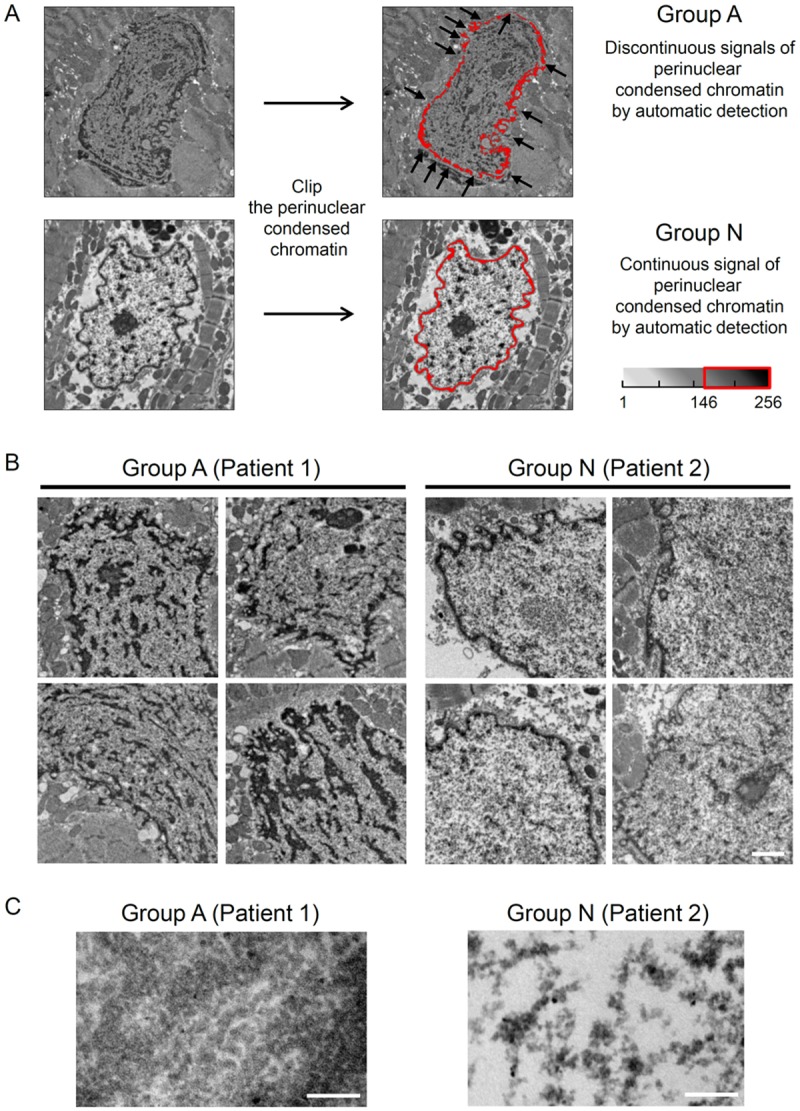
Classification of Groups A and N Based on Quantitative Analysis.(A) Representative original electron microscopic images before digital analysis are shown (10,000× magnification). The perinuclear condensed chromatin was isolated automatically using image analysis software. The area of perinuclear condensed chromatin, which is defined as the area with a grayscale value between 146 and 256, is outlined in red. Black arrows indicate areas of discontinuous nuclear periphery (discontinuous signals of perinuclear condensed chromatin by automatic detection). (B) Two types of nuclei, Group A and Group N, are shown. Representative conventional electron microscopic images (80 kV). Group A: These nuclei have discontinuous perinuclear condensed chromatin with irregular margins and unclear borders. There are homogeneous aggregations of particles in the nucleoplasm. Group N: These nuclei have continuous margins and clear borders. The granular particles in the nucleoplasm occasionally accumulate in spots, but do not aggregate closely. Scale bar: 1 μm. (C) High-power conventional electron microscopic (100 kV) images of chromatin structure in Patients 1 and 2, respectively. In Patient 1, the nucleus has an aggregated structure composed of poorly defined particles. In Patient 2, the nucleus has relatively sparse accumulations of particles less than 30 nm in size. Scale bar: 200 nm.